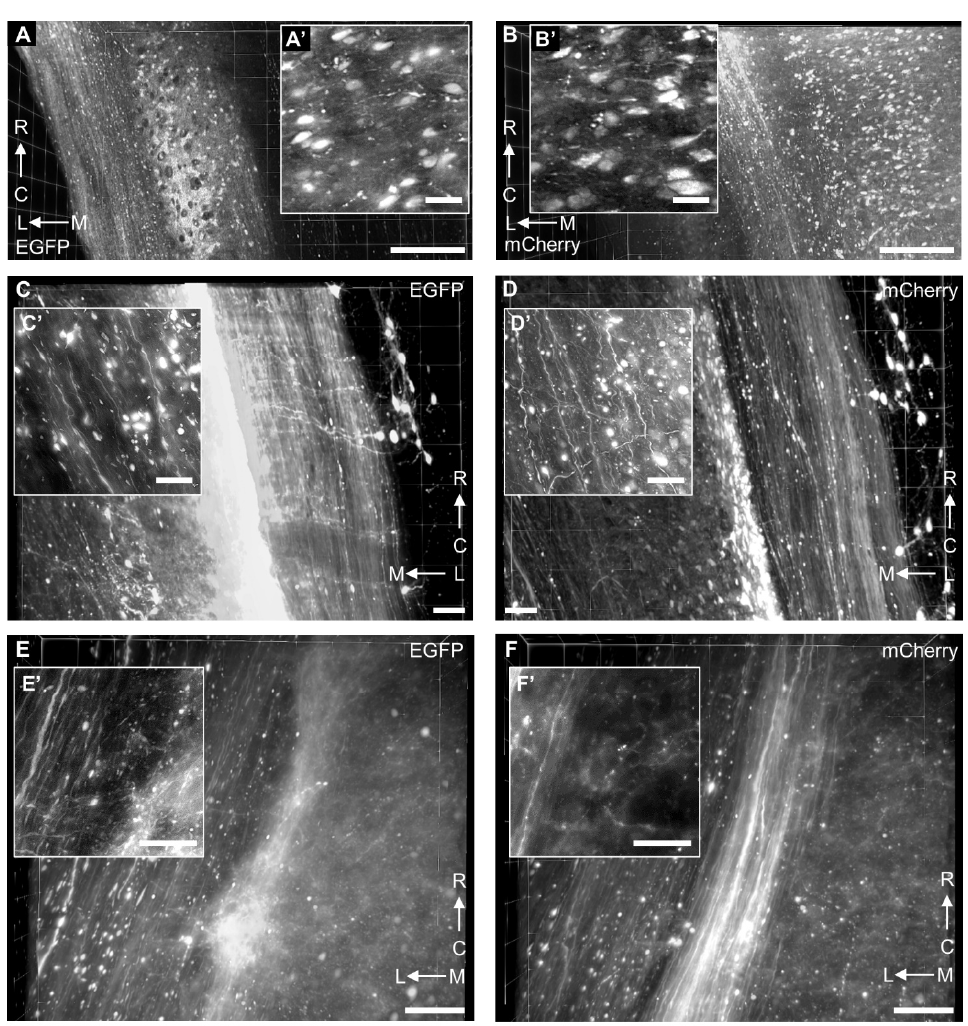
Figure 5. Three-dimensional visualization of AAV-labeled supraspinal axons in the spinal cord. ( A , B ) The representative image of EGFP + and mCherry + spinal interneurons located at the corre- sponding injection sites. ( A’ , B’ ) The high magnification of spinal interneurons captured by LSFM. The images were acquired with a Z.1 light-sheet microscopy (Zeiss, Germany) equipped with a 20×/1.0 Plan Neofluar objective at a zoom of 1.1. ( C , D ) The EGFP + and mCherry + supraspinal axons and spinal interneurons in the cervical spinal cord rostral to the injection site. ( C’ , D’ ) The high mag- nification image of EGFP + and mCherry + single axons in the gray matter captured by LSFM. ( E , F ) The EGFP + and mCherry + supraspinal axons in the middle thoracic spinal cord. ( E’ , F’ ) The high magnification image of EGFP + and mCherry + single axons in the gray matter of the middle thoracic spinal cord. M-L: midline to lateral; R-C: rostral to caudal. Scale bars: ( A , B ), 200 μ m; ( C – F ), 50 μ m; ( A’ – F’ ), 25 μ m.